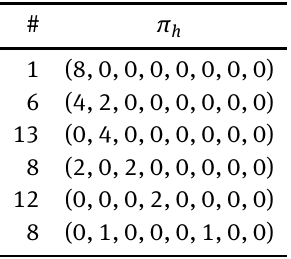
Table 4: Cycle index of B 3 in tabulated